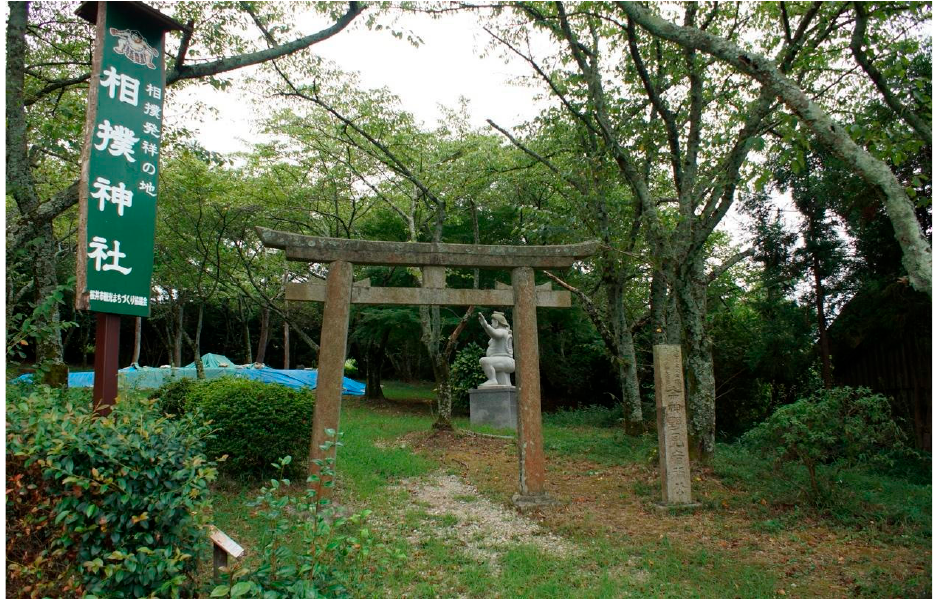
Figure 11. Entrance to Sumo Shrine, Sakurai City, Nara. Reproduced with permission from 1971; published by photolibrary.jp (image no. 5402901) (accessed on 28 August 2021).